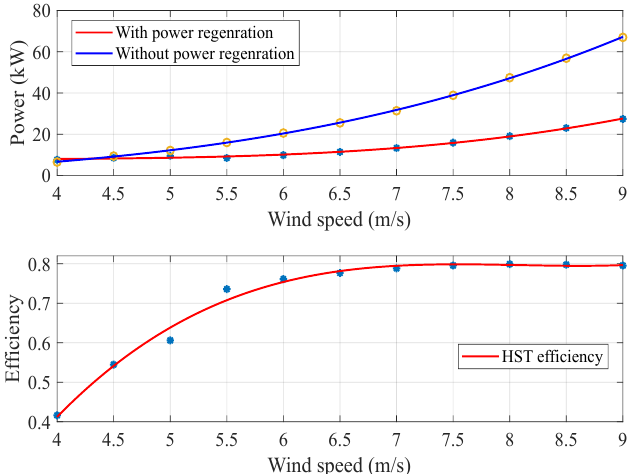
Figure 16. Power consumption during wind turbine